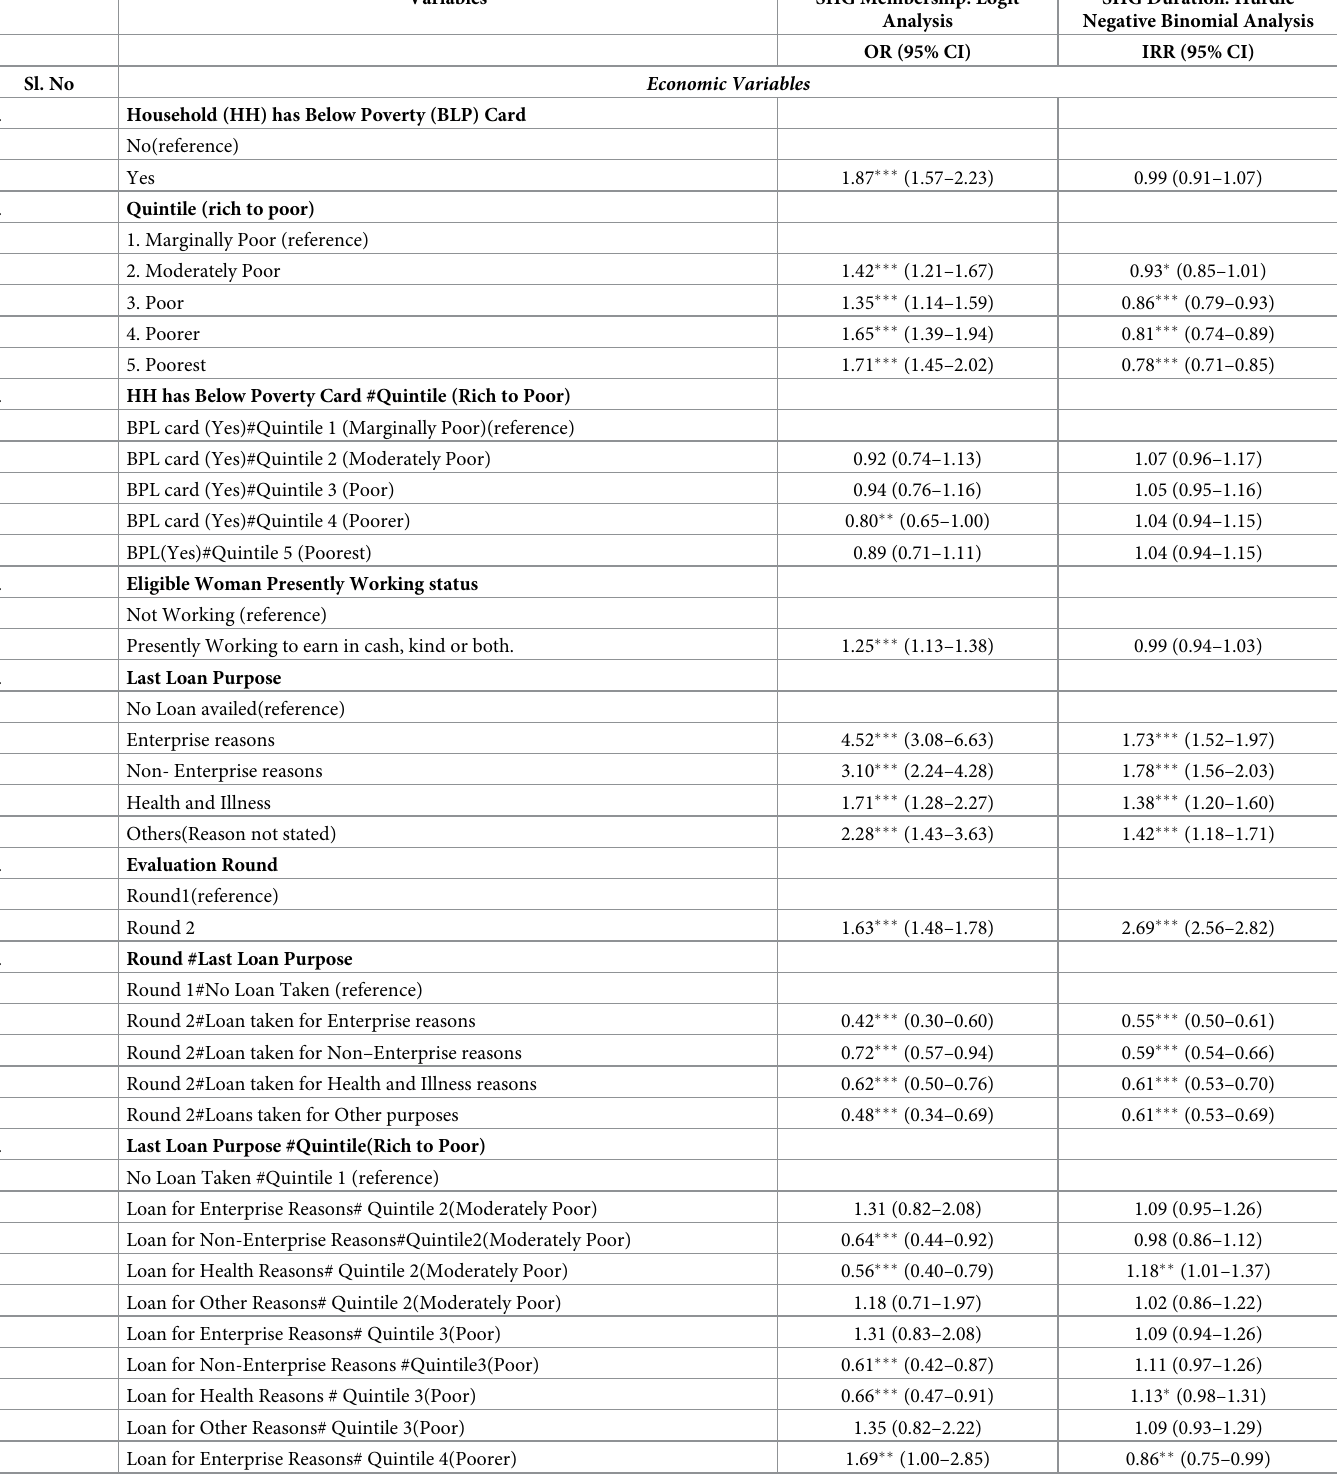
Table 2. Results from the multivariate logit regression for determinants of SHG membership and hurdle negative binomial regression for determinants of SHG duration of